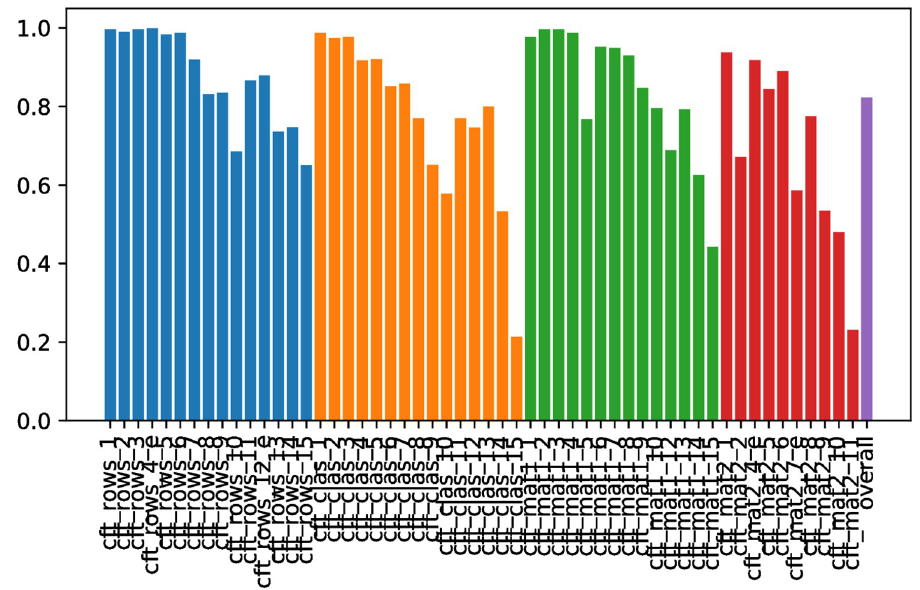
Fig 1. Success rates for each item of the CFT and a summary regarding all responses combined. The purple bar (on the very right) stands for the average success rate across all test items. The remaining colors encode the four different blocks of the